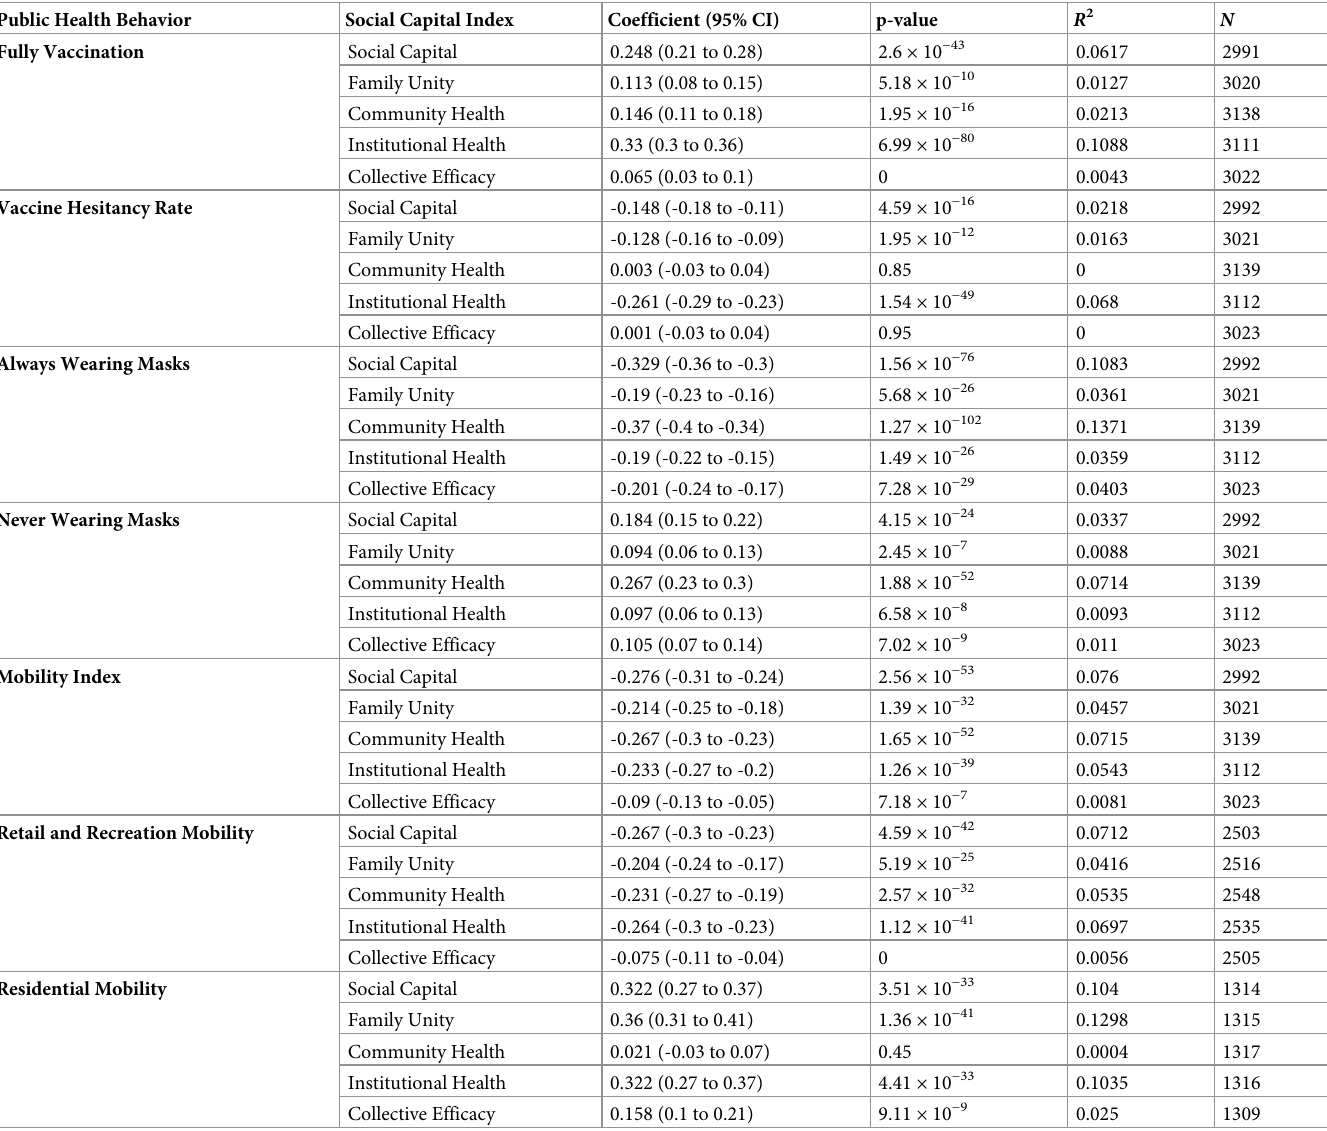
Table 2. Bivariate correlation estimation table. Each line represents a regression analysis between a public health behavior and social capital